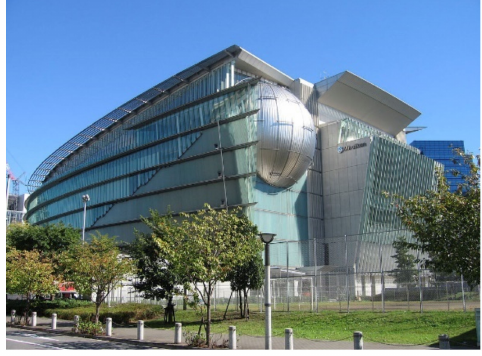
Figure 22. The National Museum of Emerging Science and Innovation (Tokyo) https://upload.